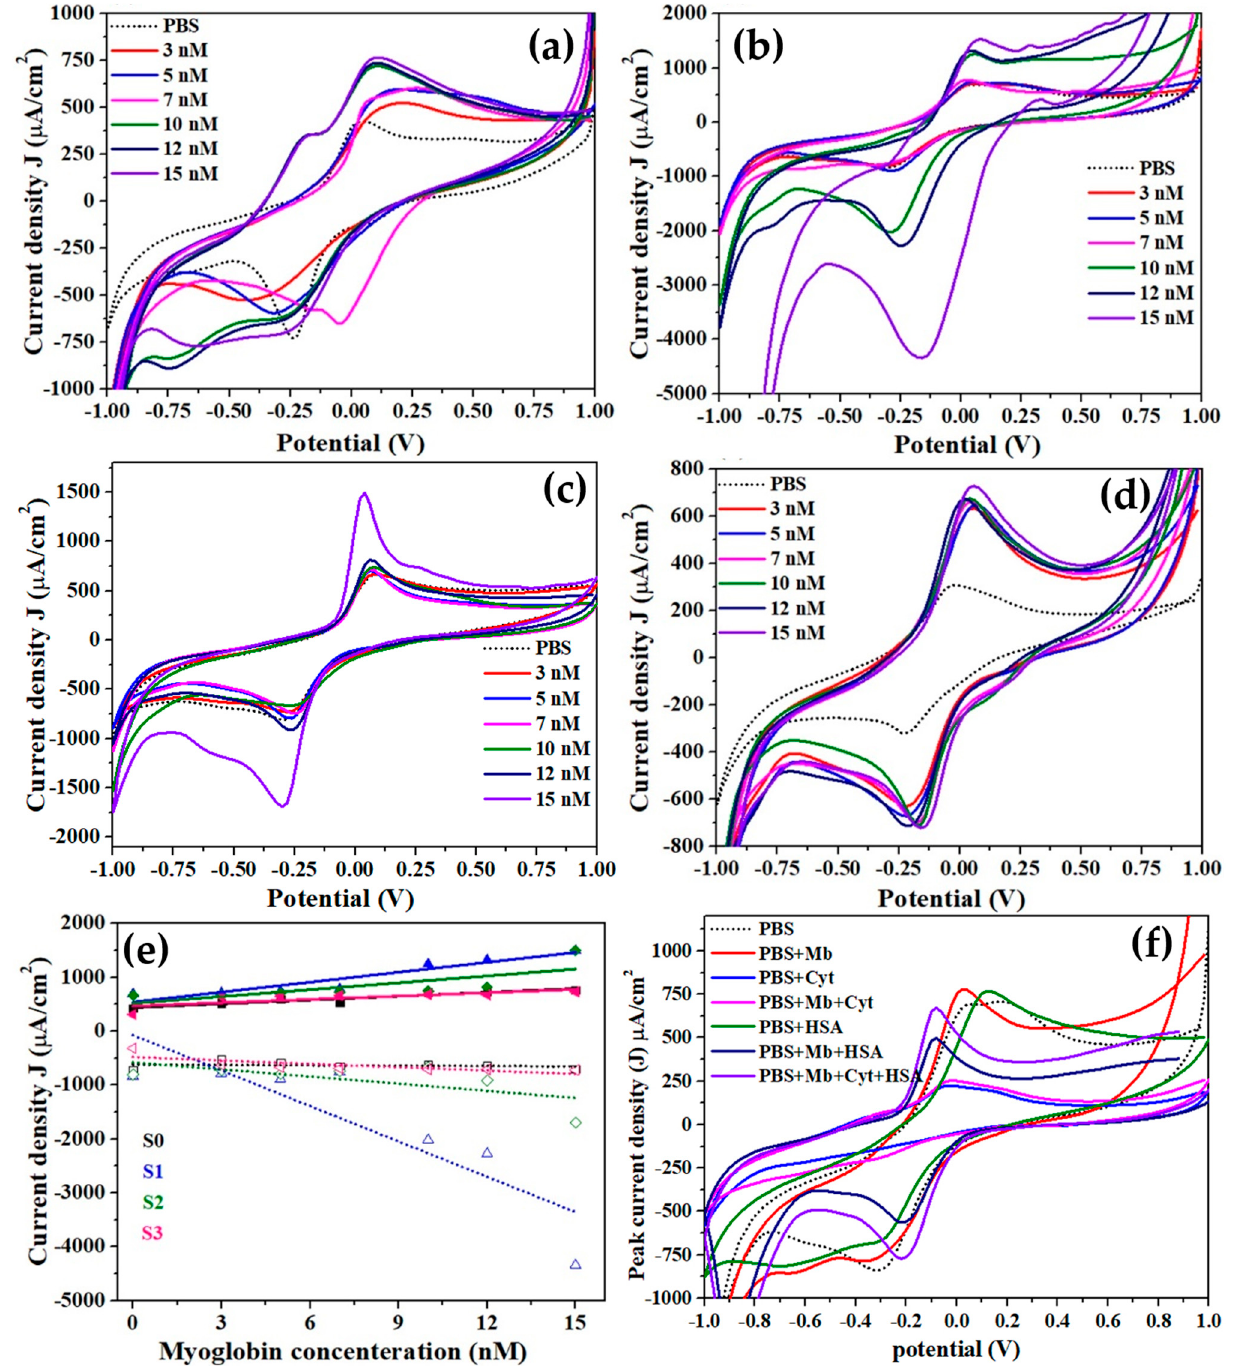
Figure 5. CV curves obtained at 100 mV/s for pure ( a ) and ( b – d ) Cu-doped TiO 2 nanomaterials in absence and presence of various concentrations of Mb. I Graph of oxidation peak current vs. Mb concentration (experimental data represented by symbols and best fit in dotted line), and ( f ) Interference study with cyt-c and human serum albumin.